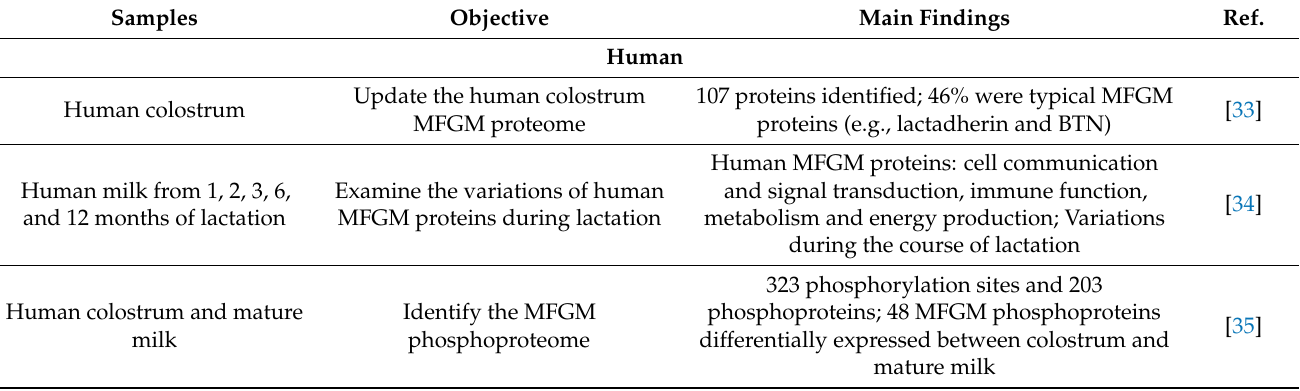
Table 1. List of research articles and reviews about comparative proteomics analyses among species and phases of lactation. Articles are listed by year and according to the different animal